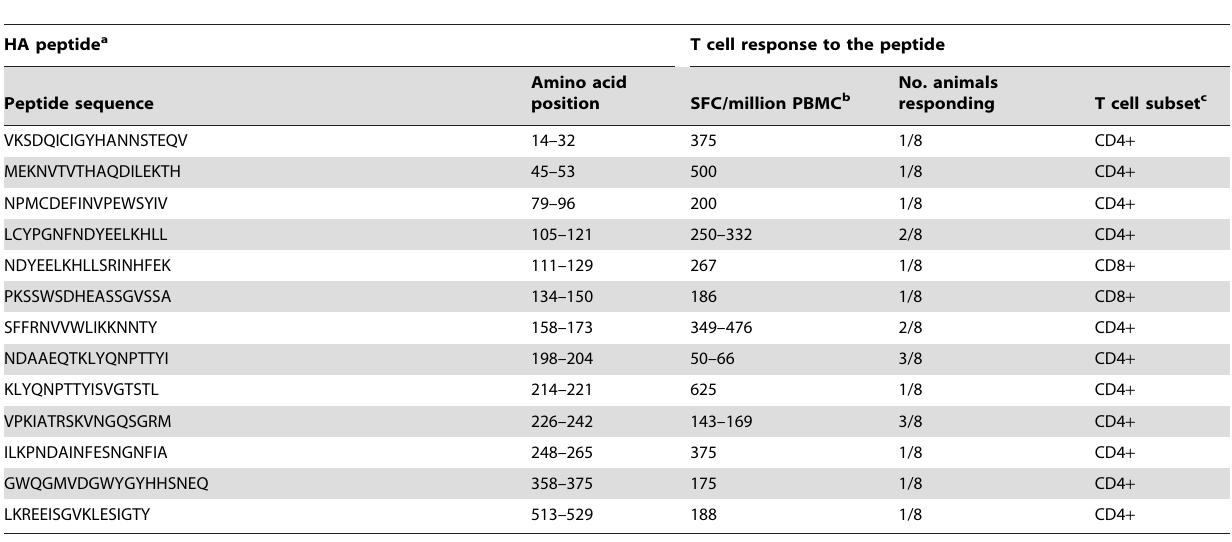
Table 4. T cell peptides and their corresponding T cell subsets against H5 HA in monkeys vaccinated with AH/AA ca .